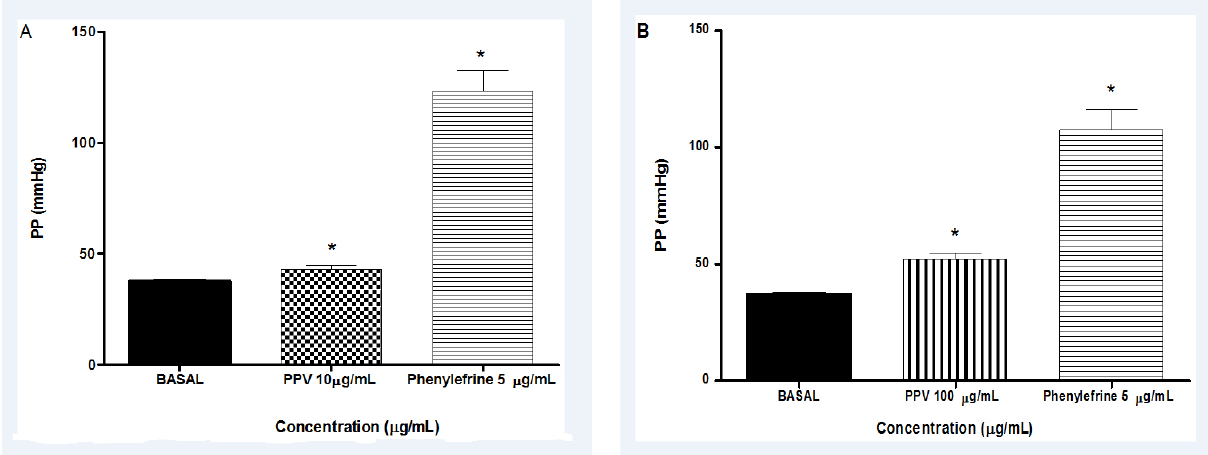
Figure 4. Effects of Polybia paulista venom (PPV) at concentrations of ( A ) 10 µg/mL and ( B ) 100 µg/mL on perfusion pressure (PP) of arteriolar mesenteric beds. *p < 0.05 compared with basal pressure.